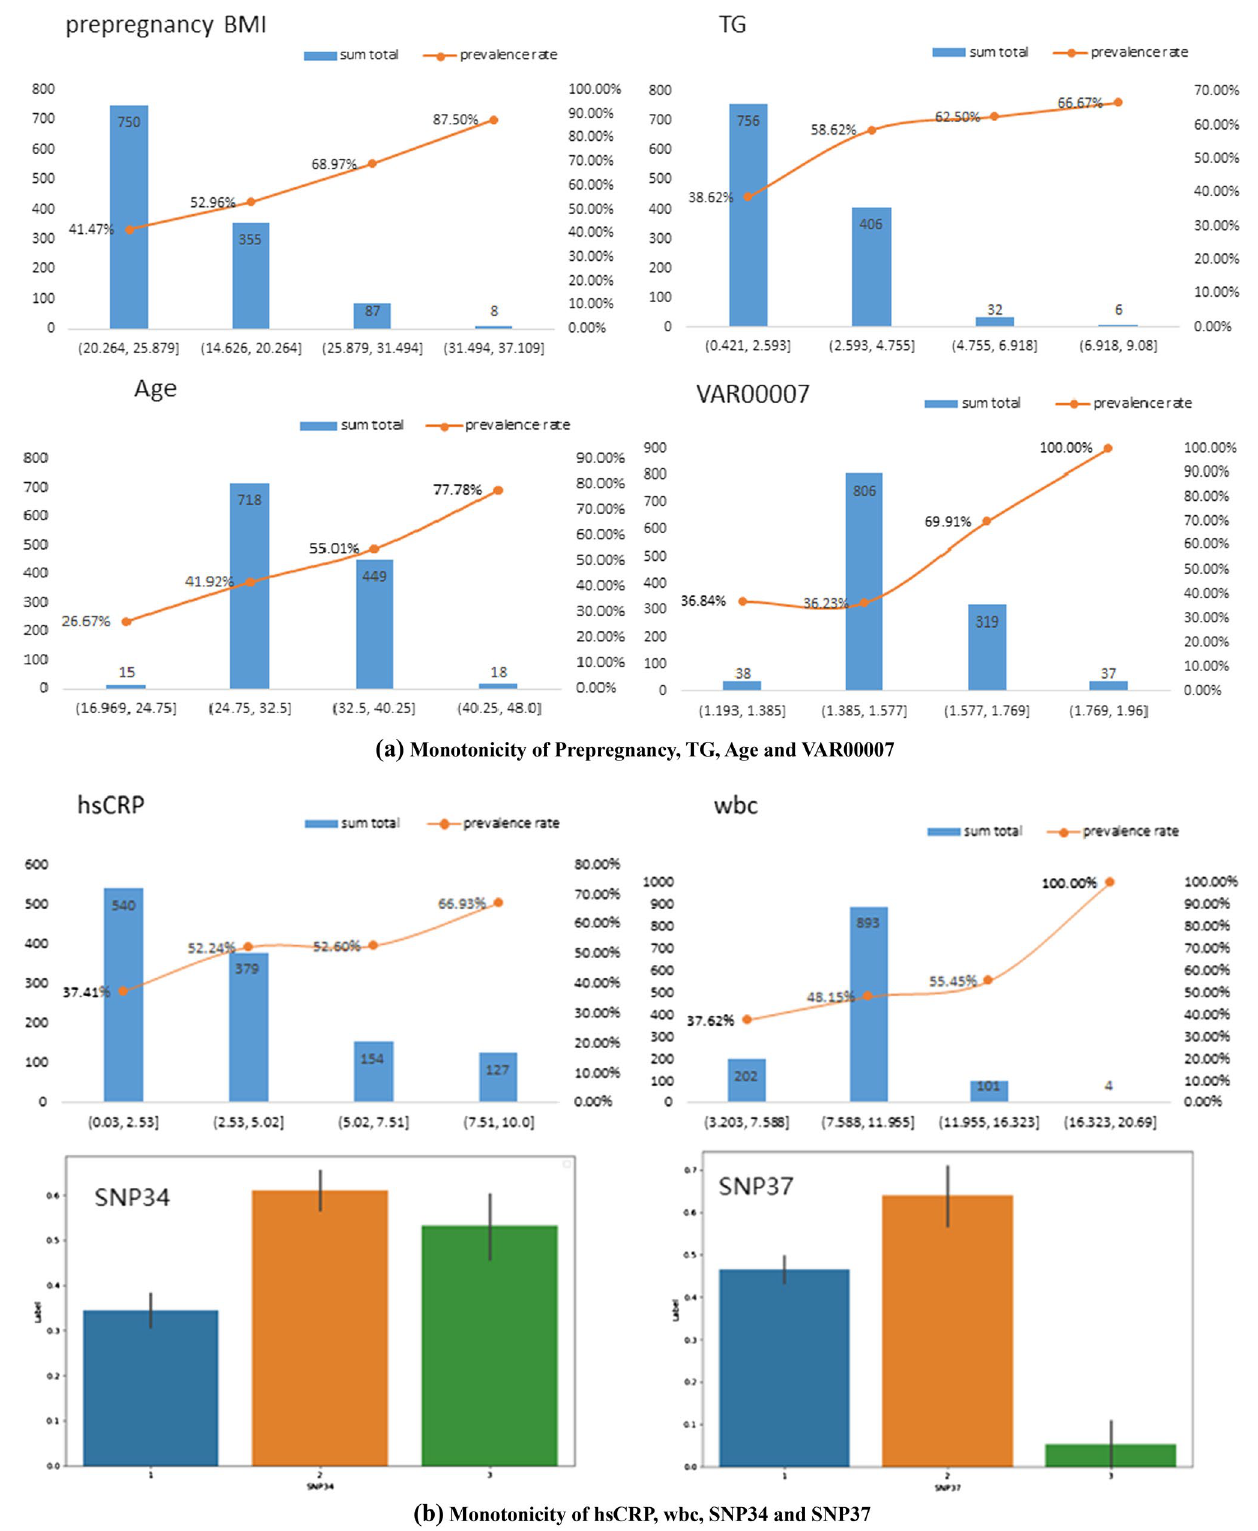
Fig. 5 a Monotonicity of Prepregnancy, TG, Age and VAR00007. b Monotonicity of hsCRP, wbc, SNP34 and